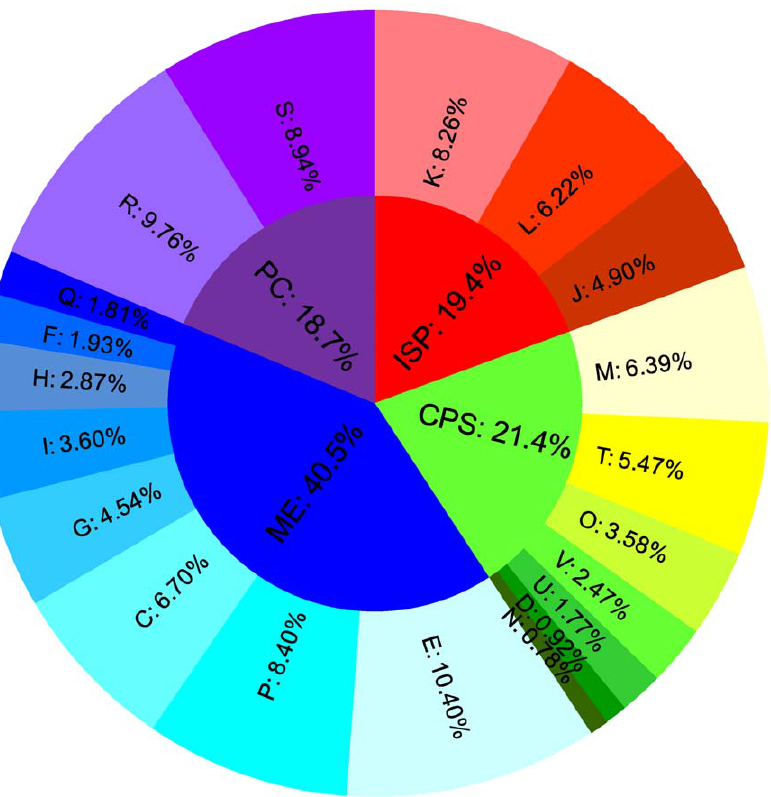
Figure 4. COG classification of the symbiotic bacteria in B.tabaci . ME: Metabolism; CPS: Cellular processes and signaling; ISP: Information storage and processing; PC: Poorly characterized (inside circle); Q: Secondary metabolites biosynthesis, transport and catabolism; F: Nucleotide transport and metabolism; H: Coenzyme transport and metabolism; I: Lipid transport and metabolism; G: Carbohydrate transport and metabolism; C: Energy production and conversion; P: Inorganic ion transport and metabolism;E: Amino acid transport and metabolism; N: Cell motility; D: Cell cycle control, cell division, chromosome partitioning; U: Intracellular trafficking, secretion, and vesicular transport; V: Defense mechanisms; O: Posttranslational modification, protein turnover, chaperones; T: Signal transduction mechanisms; M: Cell wall/membrane/envelope biogenesis; J: Translation, ribosomal structure and biogenesis; L: Replication, recombination and repair; K: Transcription; S: Function unknown; R: General function prediction only.